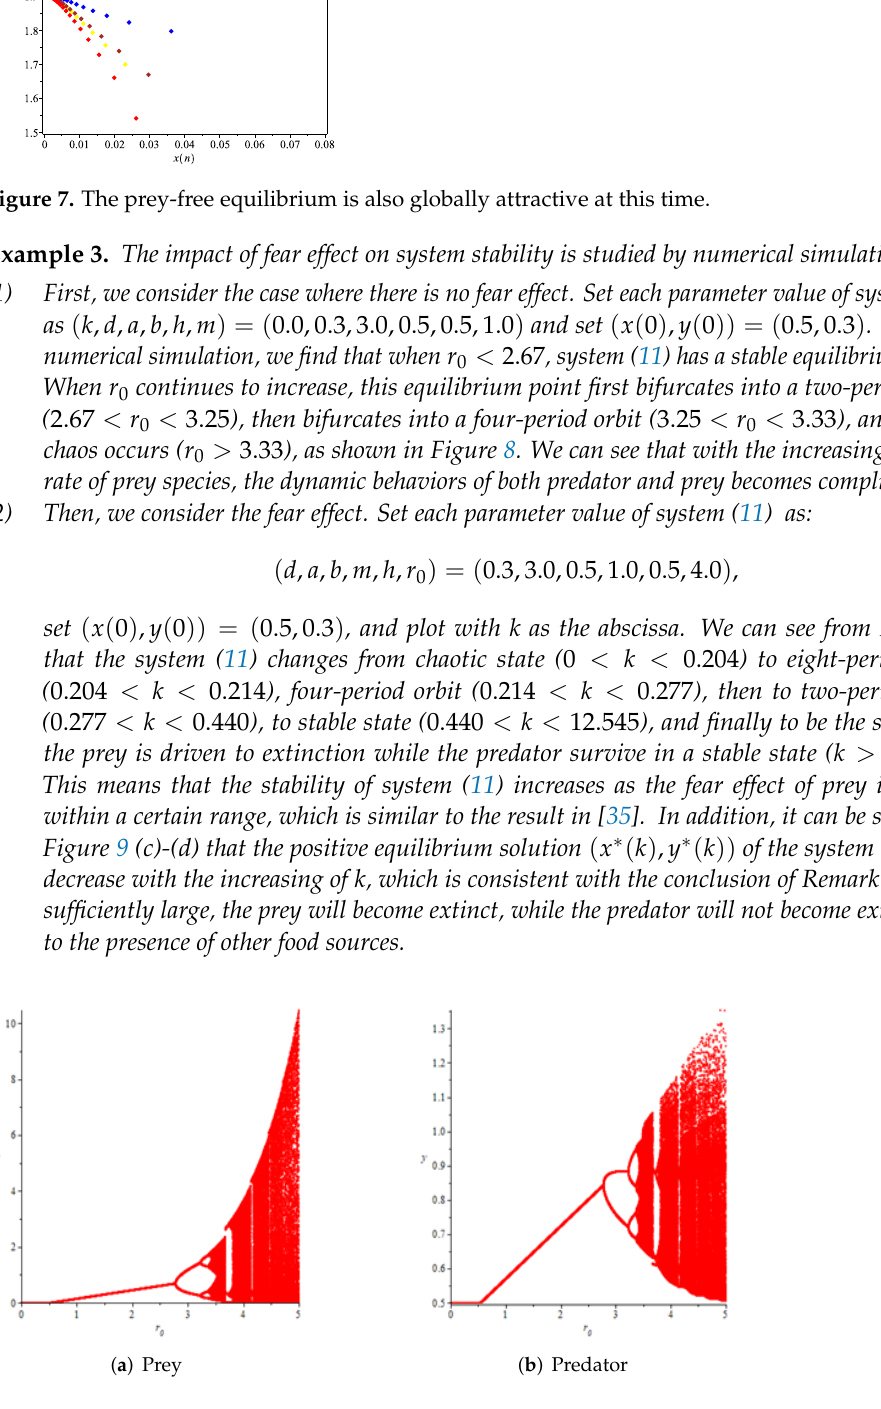
Figure 8. Variation of prey and predator densities with parameter r 0 ( k =